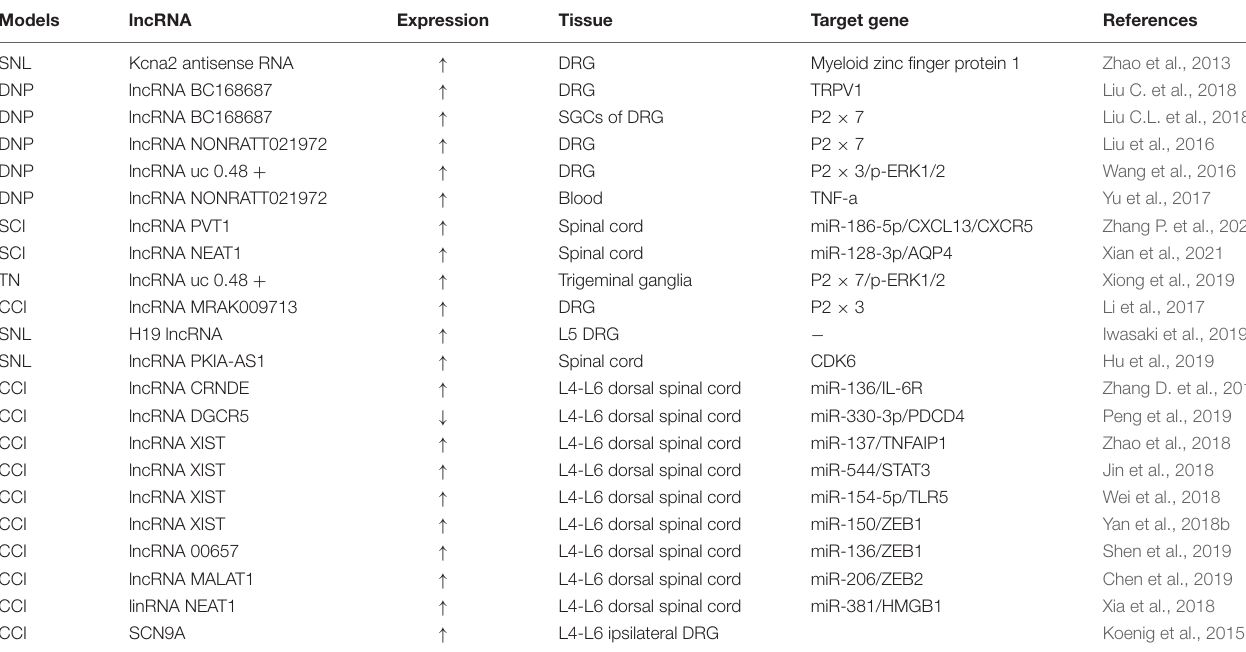
TABLE 2 | lncRNAs associated with neuropathic pain.